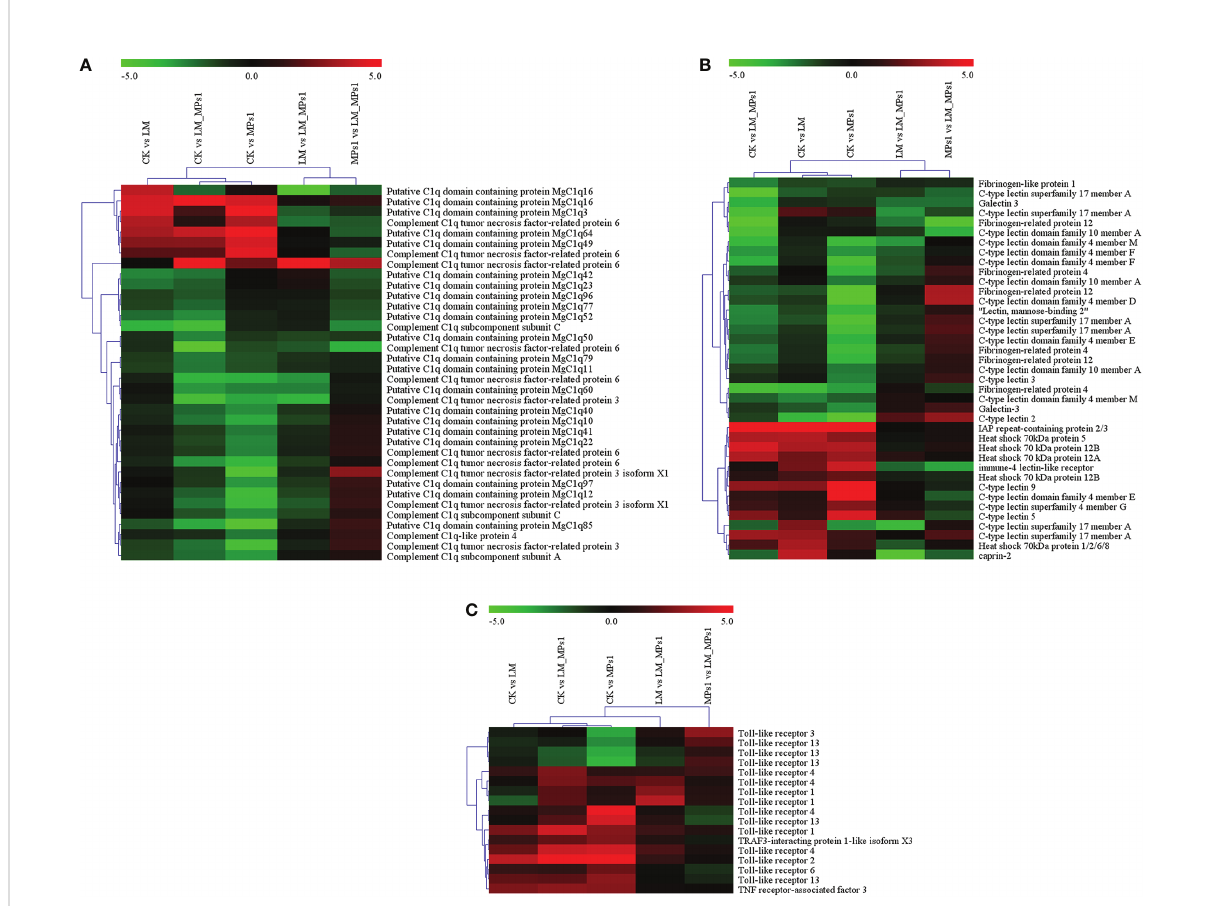
FIGURE 7 Heatmap analysis of immune-related gene expression in different groups at the transcriptome level. (A) , C1q domain protein; (B) , Some immune-related genes; (C) , Toll-like receptor and TRAF3 genes. The color panel represents the changes in gene expression levels from down- regulated (green) to up-regulated (red).